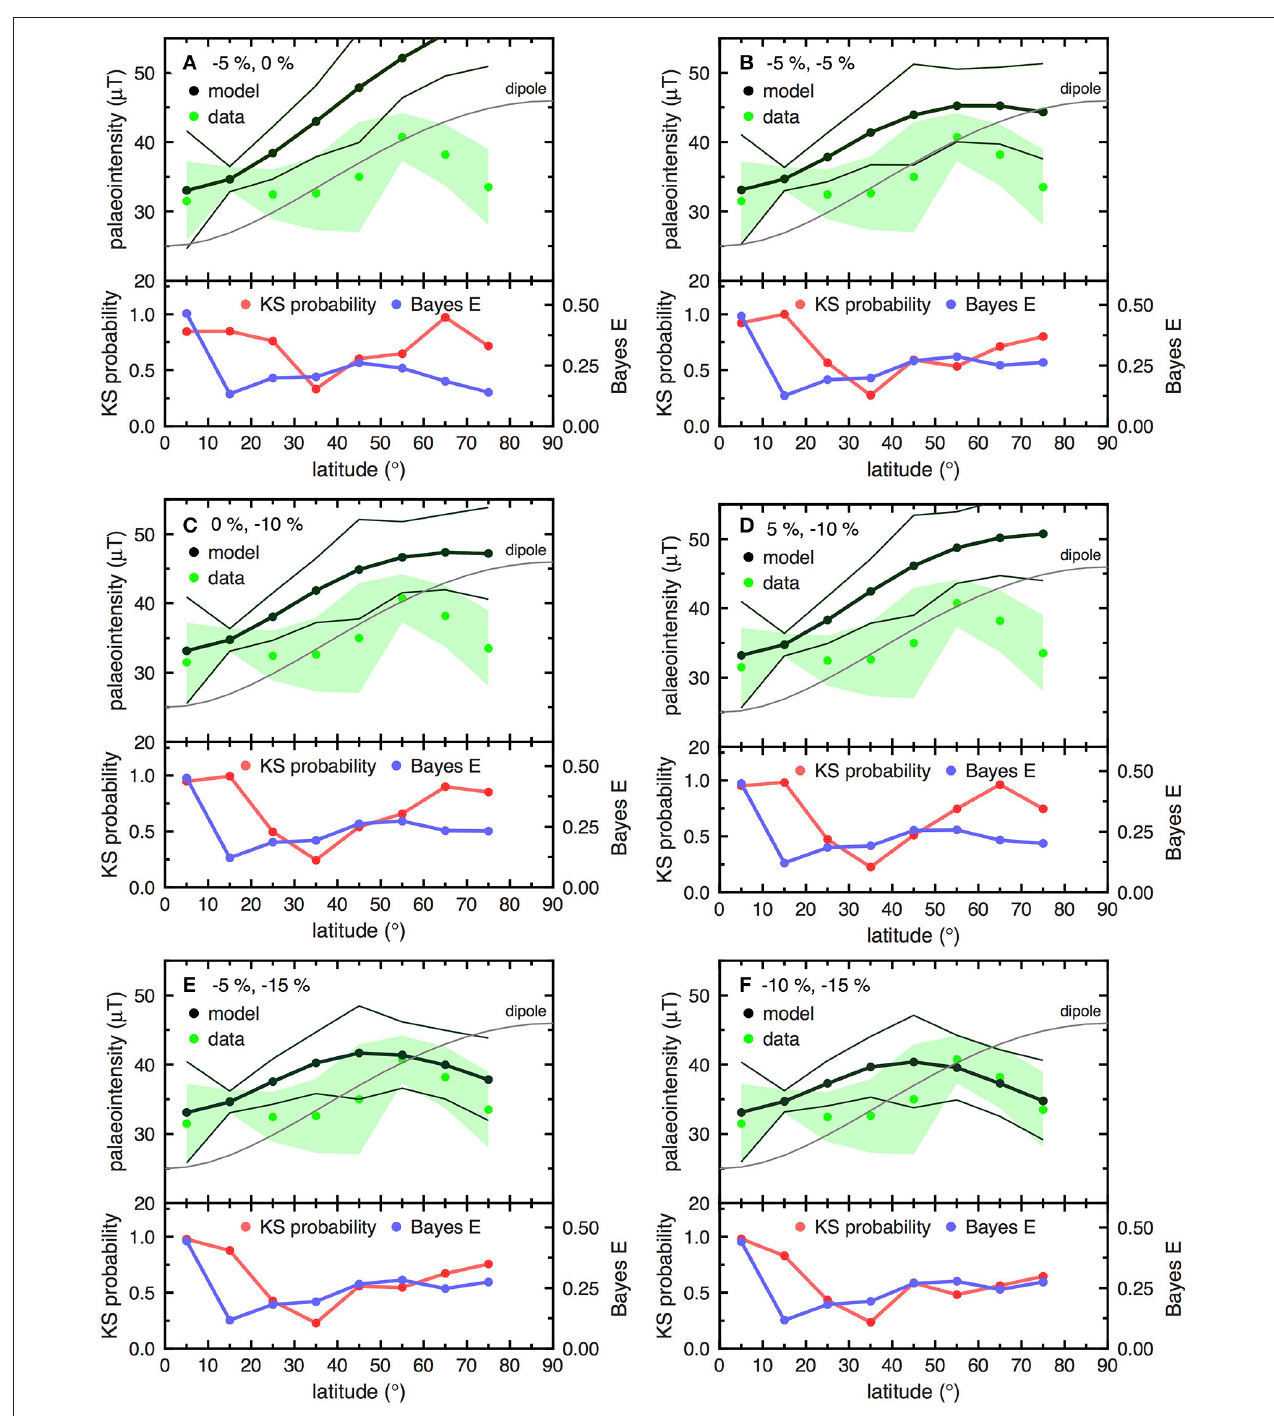
FIGURE 5 | GGP model intensity predictions vs. latitude for: (A) g 0 2 ≈ − 0.05 g 0 1 ( − 5%) and g 0 3 ≈ 0 (0%), (B) g 0 2 ≈ − 0.05 g 0 1 and g 0 3 ≈ − 0.05 g 0 1 , (C) g 0 2 ≈ 0 and g 0 3 ≈ − 0.1 g 0 1 , (D) g 0 2 ≈ 0.05 g 0 1 and g 0 3 ≈ − 0.1 g 0 1 , (E) g 0 2 ≈ − 0.05 g 0 1 and g 0 3 ≈ − 0.15, and (F) g 0 2 ≈ − 0.1 g 0 1 and g 0 3 ≈ − 0.15 g 0 1 . Included are the binned palaeointensity data (green dots) from the PINT palaeointensity database. The northern and southern hemisphere data are combined; there is no data > 80 ◦ , 95% confidence intervals are plotted for the PINT data (shaded green) and the model data (black lines). Additionally, the standard dipole model (Equation1) is also calculated, with B D eq = 25 µ T (gray line). In the lower section of the figures the Kolmogorov-Smirnov probability and the Bayes error E are plotted as a function of latitude.